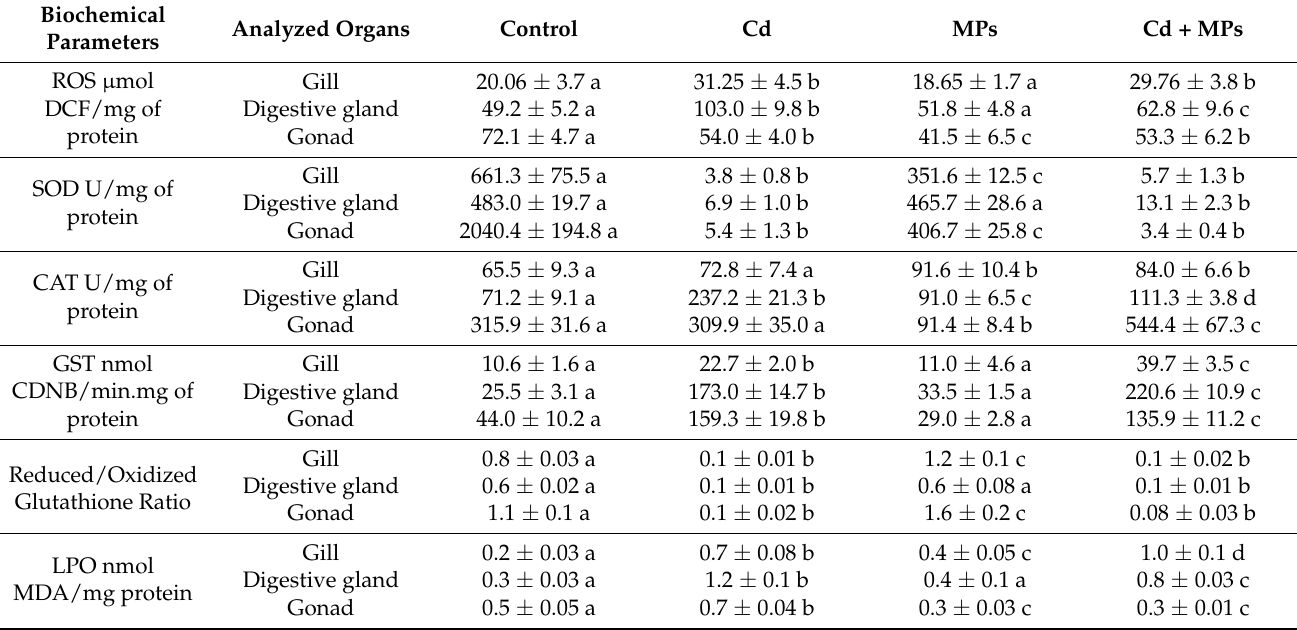
Table 2. Biochemical biomarkers activities in gill, digestive gland and gonad of Corbicula fluminea after exposure to Cd and/or MPs for 7